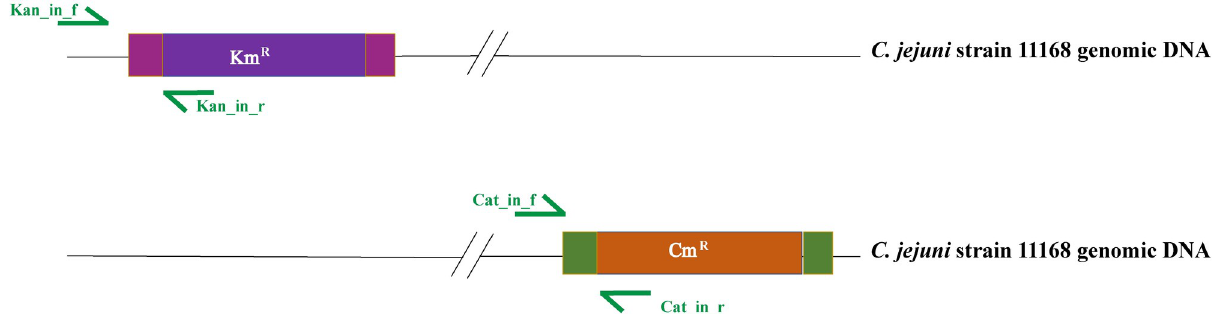
Fig 3. Primer locations used to amplify the insertion junction of antibiotic markers in marker